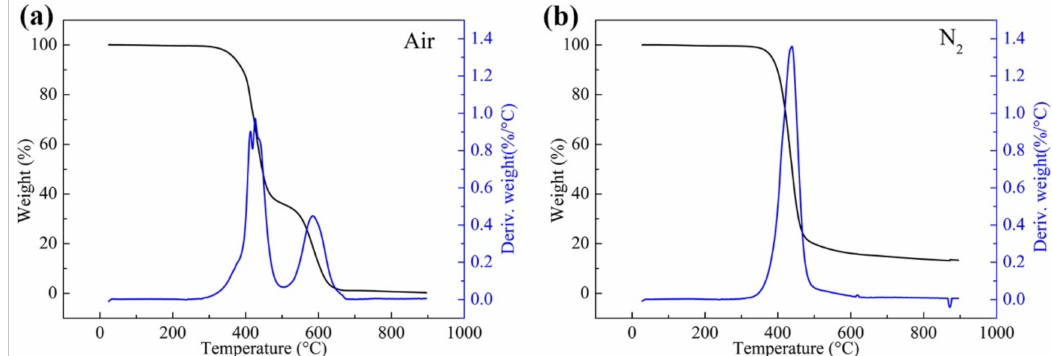
Figure 6. TG and DTG curves of the matrix resin in ( a ) air and ( b ) nitrogen